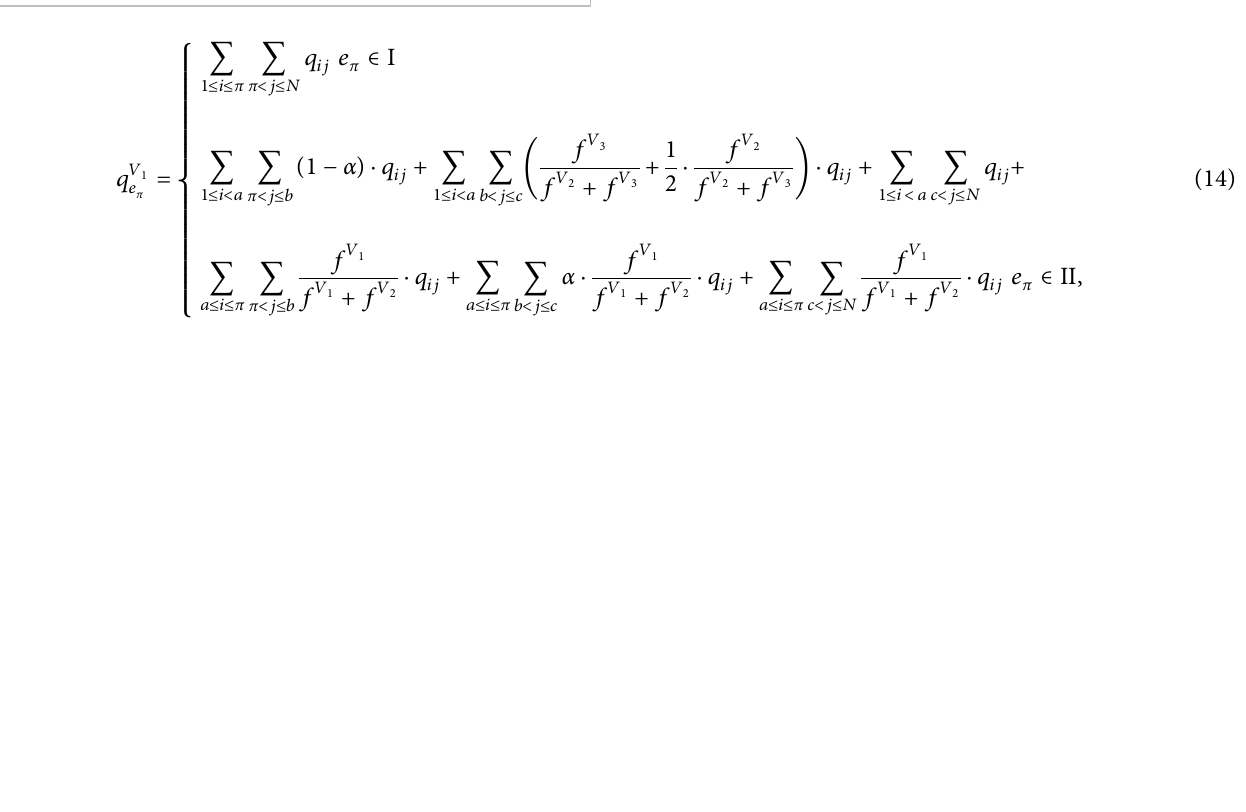
Figure 5: Travel path of passengers taking V e , e ∈ π π